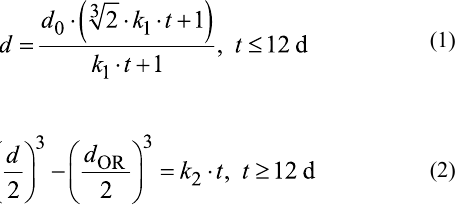
Table 1: Composition of diamond shaped nanoparticles at different stages of the growth process as determined by EELS. Time